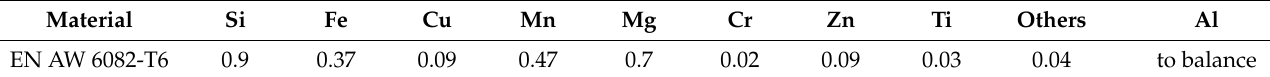
Table 1. Chemical composition of EN AW 6082 T6 aluminum alloy (% weight).